Question: Summarize what this figure shows in one sentence.
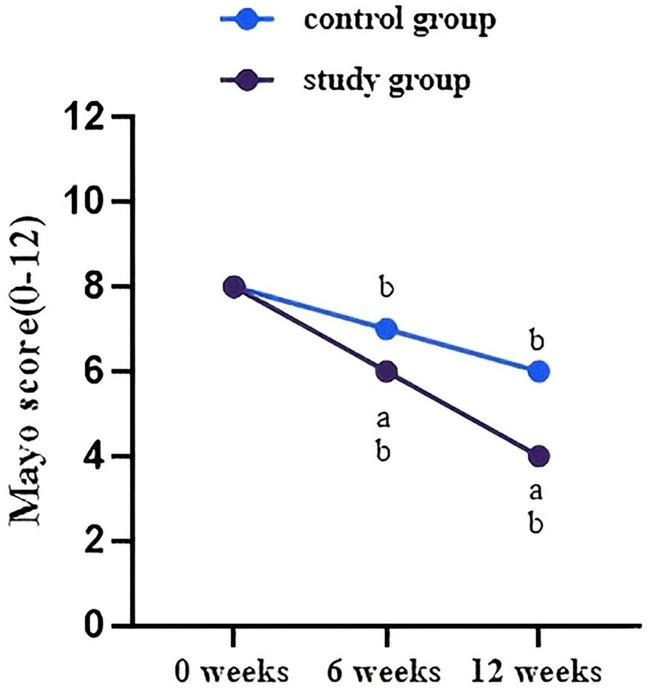
Answer: Dynamic changes of TCM syndrome scores in the two groups at different time points. a P < 0.05 vs. control group; b P < 0.05 vs. baseline (0 weeks). 6 weeks: inter-group difference 95% CI: 2.31–3.97; 12 weeks: inter-group difference 95% CI: 2.98–4.48.